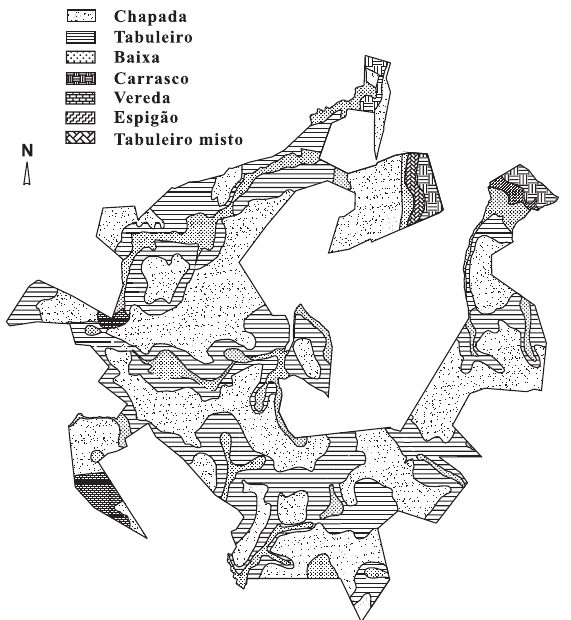
Figura 3. Distribuição dos diferentes ambientes reconhecidos pelos agricultores e extrativistas no Projeto de Assentamento